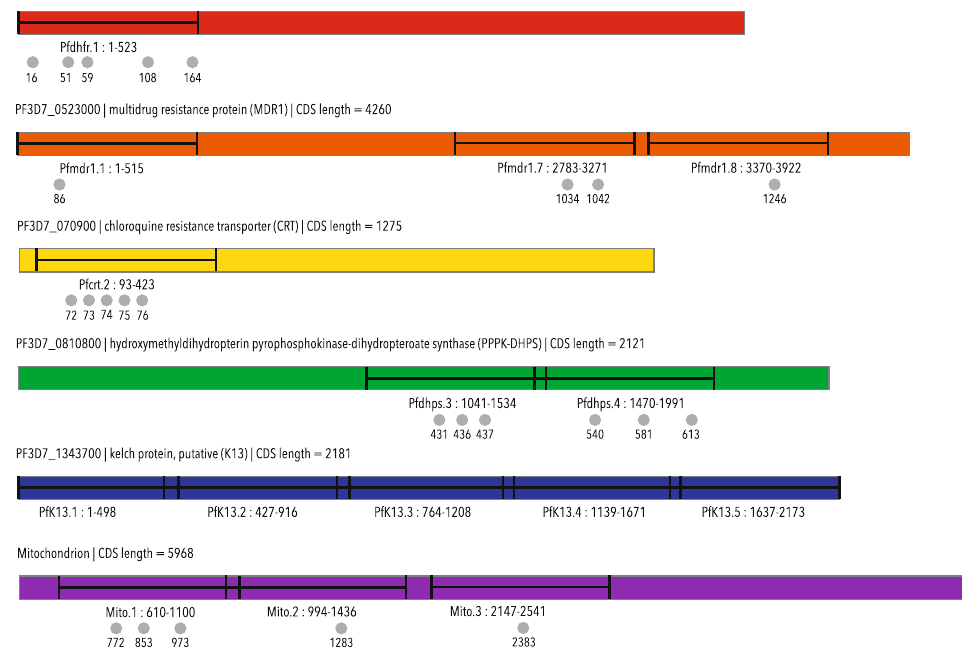
Figure 3. Amplicon design. In the current study, we have analysed one fragment including five SNPs in pfdhfr , three fragments including four SNPs in pfmdr1 , one fragment including five SNPs in pfcrt , two fragments including six SNPs in pfdhps , all of pfK13 , and three fragments including five SNPs in the mitochondrial genome of P. falciparum . The figure illustrates the length and placement of the fragments in the different genes, as well as the nucleotide/codon positions of the SNPs of